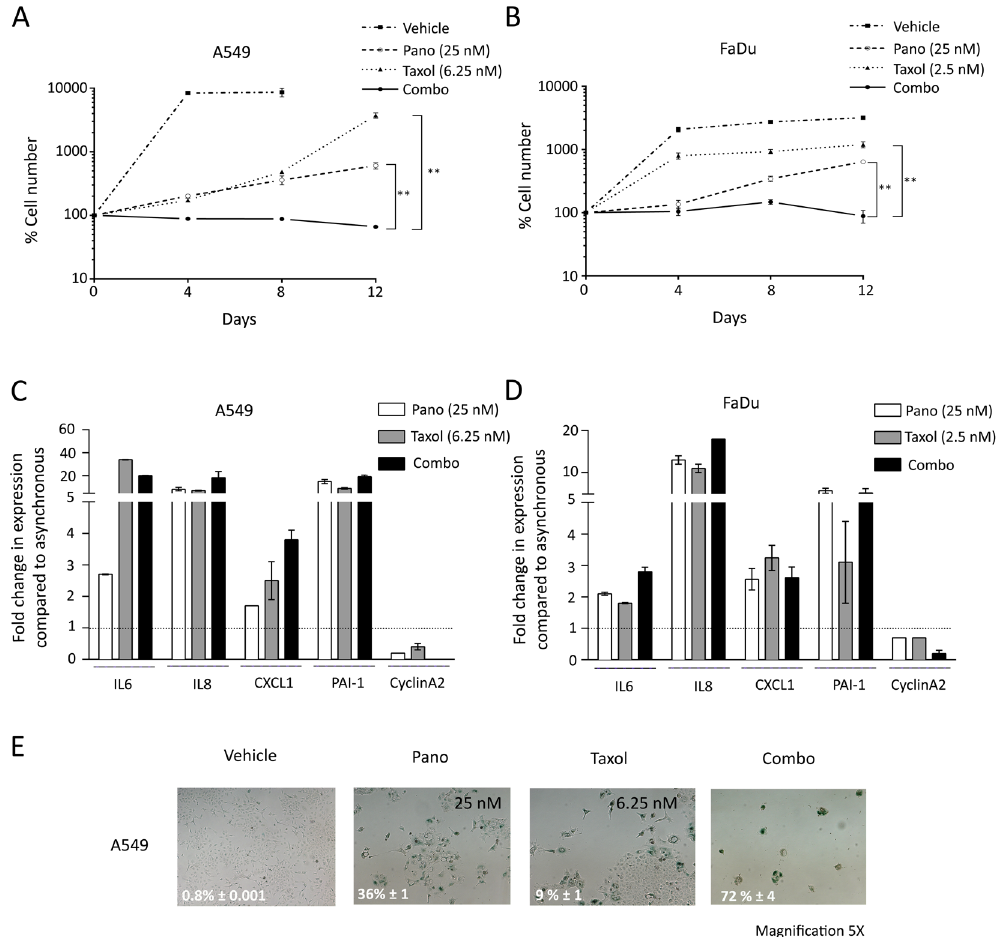
Figure 2. The Combination of Taxol and Pano is Synergistic due to Senescence Induction. Representative proliferation assays for ( A ) A549 and ( B ) FaDu showing sustained proliferative arrest in combination-treated cells. Cells treated with single agents exhibited transient proliferative arrest. The statistical significance (unpaired t -test) for combination-treated cells relative to single agents on day 12 is indicated. Transcriptome analysis (qRT-PCR) of SASP-associated genes (IL6, IL8, CXCL1, PAI-1) and proliferation (cyclin A2) in 6 day drug-treated ( C ) A549 and ( D ) FaDu cells. Increased SASP expression and absence of proliferation are typical of senescence. Bar represents mean ± SD ( n = 3). ( E ) Representative images of SA- β -gal-stained A549 cells after 6 days treatment with the indicated doses of Taxol, pano or combo. SA- β -gal quantitation (bottom left) are indicated (mean ± SD). Magnification